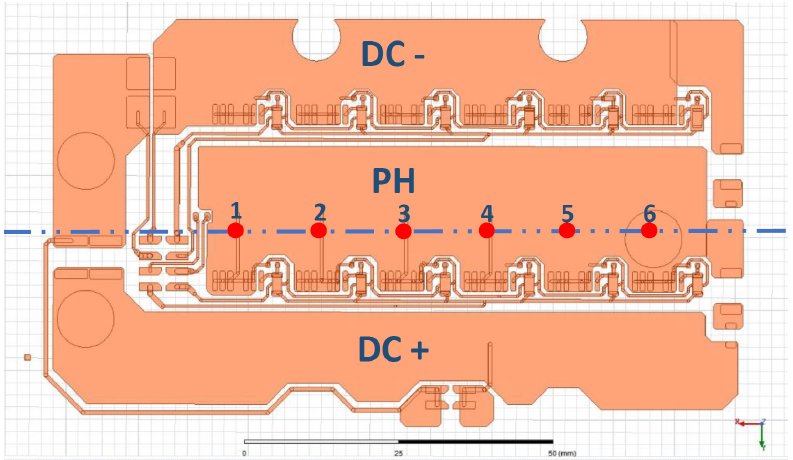
Figure 9. Complete activation of PH, DC+, and DC − nets. Points labeled from 1 to 6 are the points between which parasitic resistances and inductances were